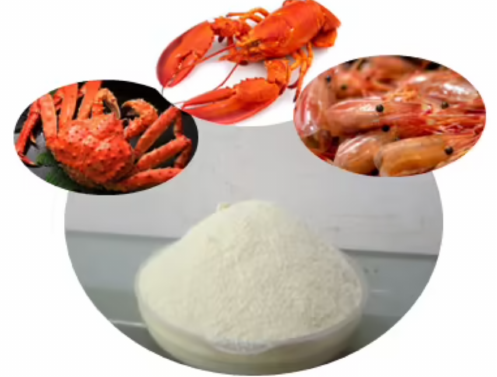
Figure 1. Chitosan from marine crustacean products (picture adopted from https://zenonco.io/ cancer/chitosan/ accessed on 2 February